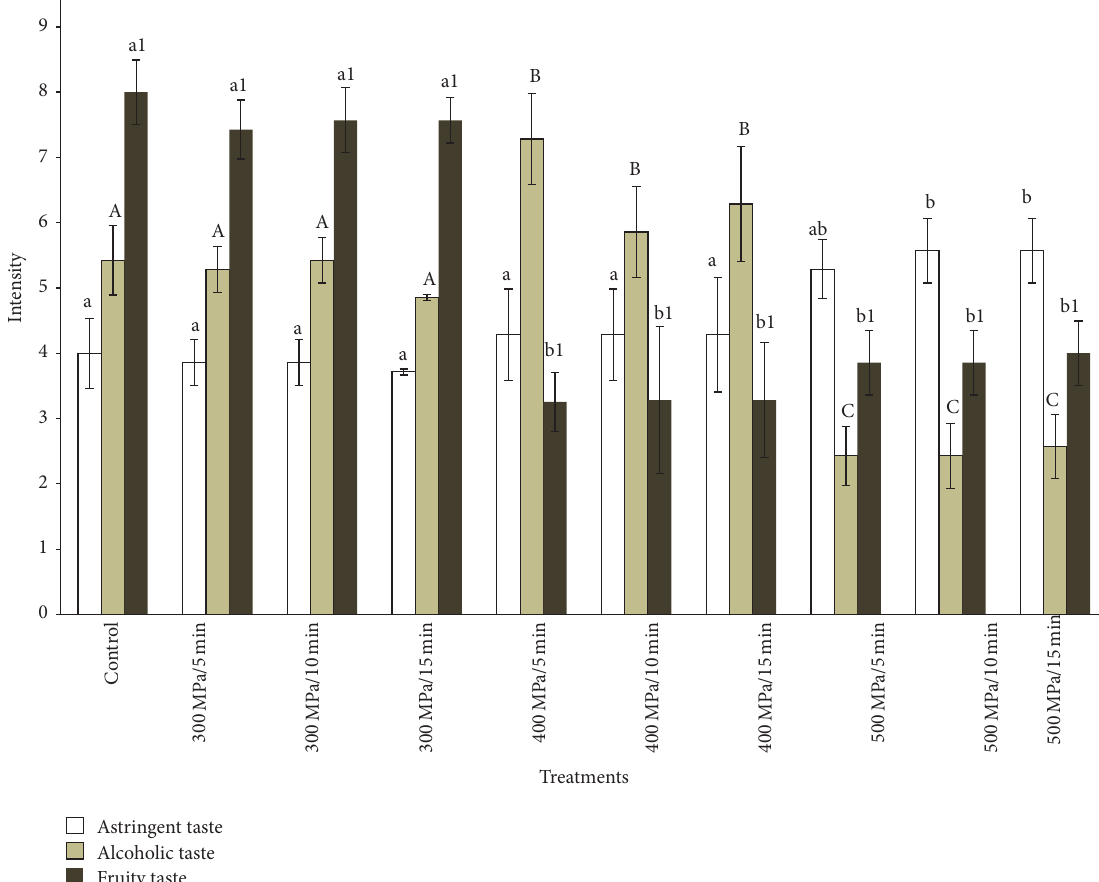
Figure 4: Effects of HHP on white wine sensory attributes. Different letters in each bar indicate significant differences between mean values ( 𝑝 ≤ 0.05